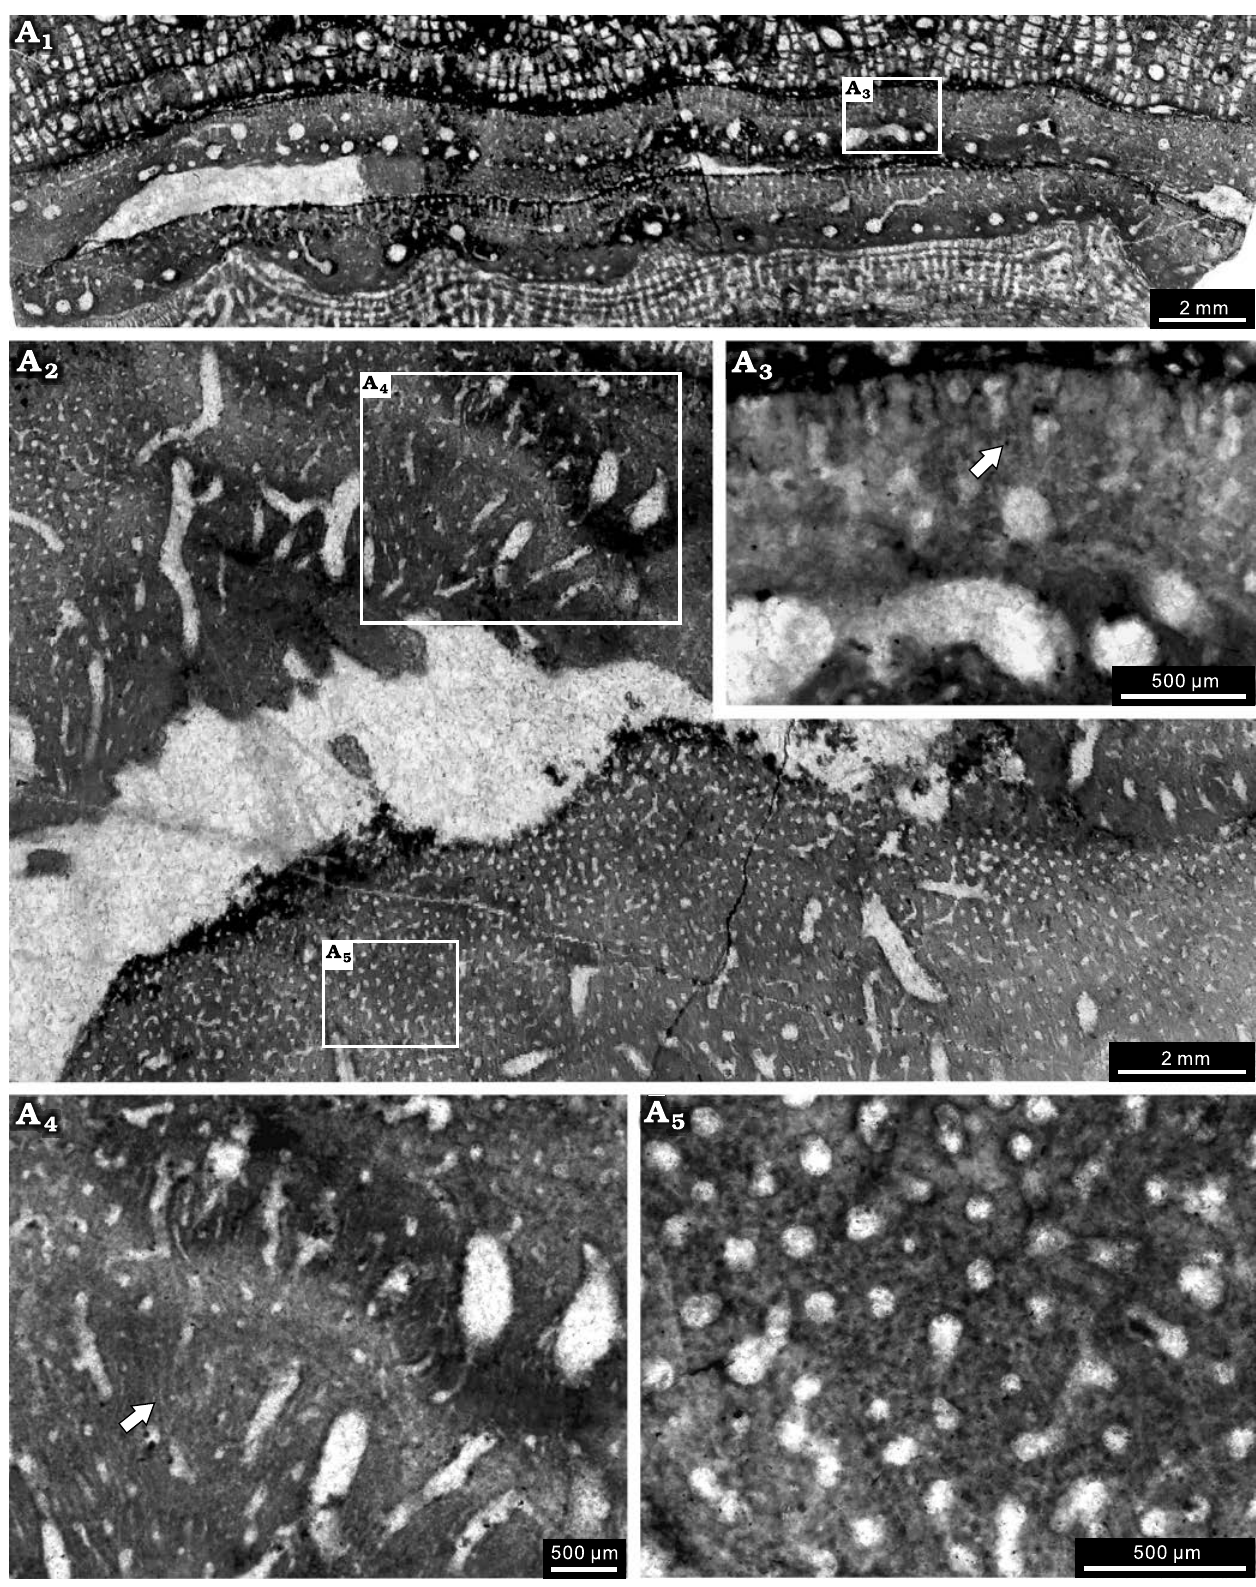
Fig. 12. Stromatoporoid Stachyodes sp. NIGP 177063, from the Jiwozhai reef, Jiwozhai Member, Dushan Formation, Givetian, Middle Devonian; Dushan, Guizhou, South China. A 1 , longitudinal section; A 2 , tangential section, note the autotubes and conspicuous astrorhizal canals; A 3 , enlargement of A 1 , note the coarsely striated microstructure (arrow); A 4 , enlargement of the upper middle part of A 2 , note the probably striated microstructure (arrow); A 5 , enlargement of the lower left part of A 2 , note the black dots in the tangential